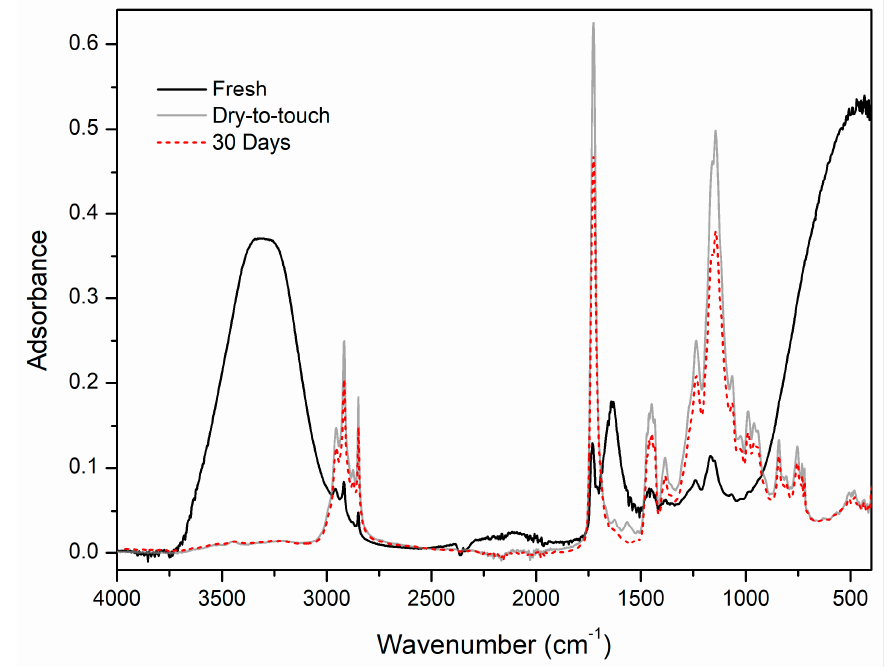
Figure 1. FT-IR-ATR spectra of fresh, dry-to-touch film and 30 days Edelwachs films.